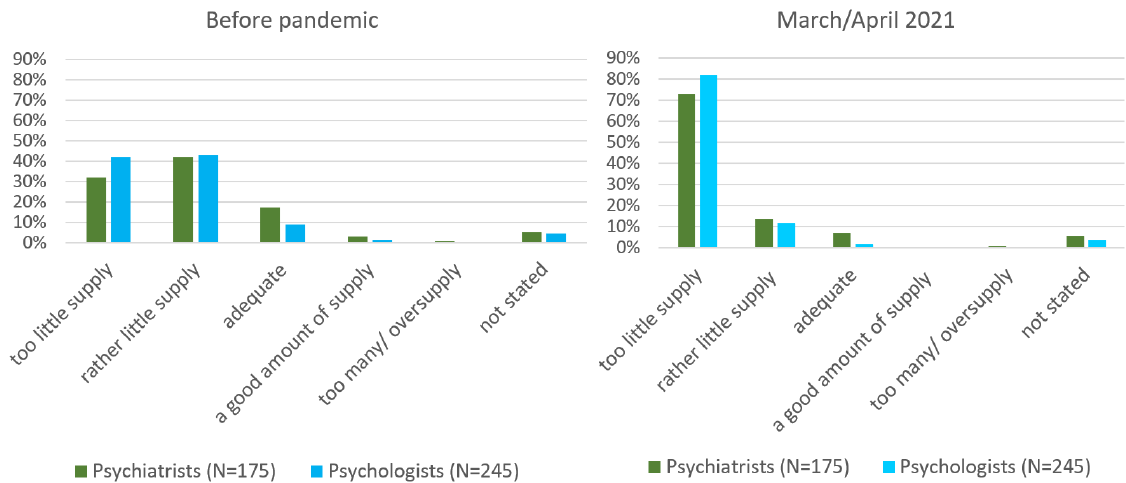
Figure 2. Evaluation of the amount of treatment supply for children and adolescents before the pan- demic and in March/April 2021 by psychiatrists and psychologists (percent of responses).